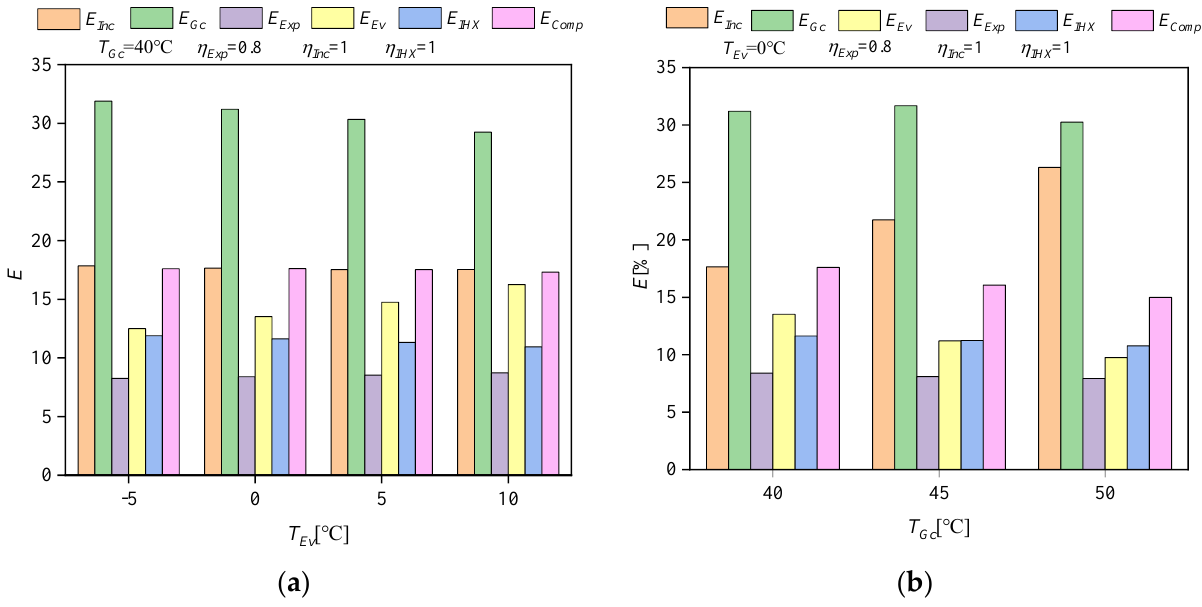
Figure 13. Effect of temperature on the system’s components exergy loss percentage: ( a ) The effect of T e ; ( b ) The effect of T gc .